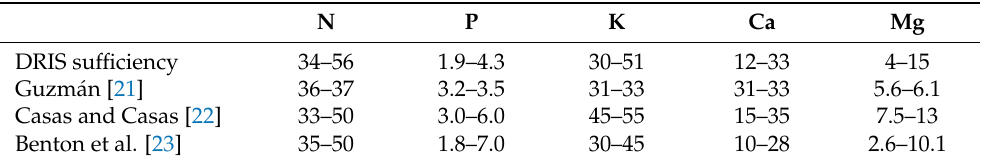
Table 3. Comparative study of general ranges DRIS delivered optimum foliar nutrient concentration ranges for pepper with published sufficiency ranges (mg g − 1 DW).